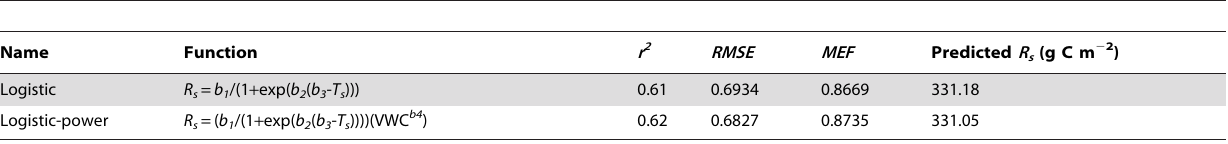
Table 3. Comparison of combined soil respiration ( R s ) model (Logistic-power) with both soil temperature ( T s ) ( u C) and soil water content (VWC) (m 3 m 2 3 ) as predictors and temperature-only